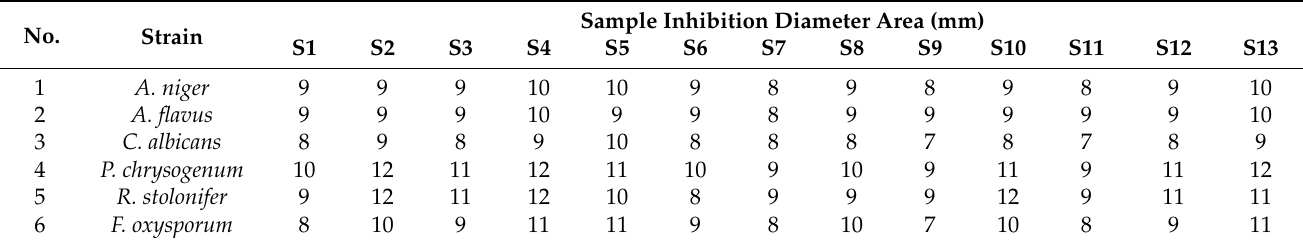
Table 7. Diameters of the inhibition zones on the fungal strains for honey samples from North-West and Central Romania.